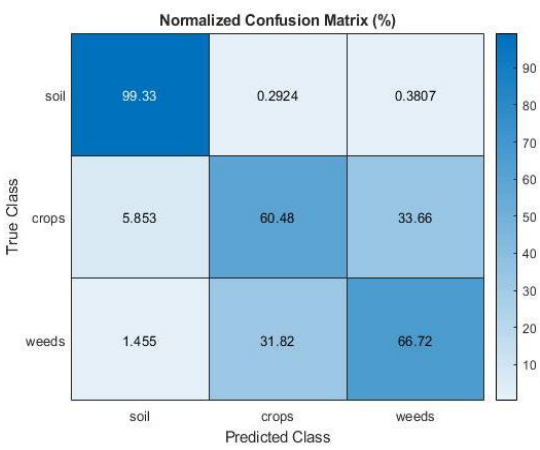
Table 1. Confusion matrix of U-Net Classification (unit-